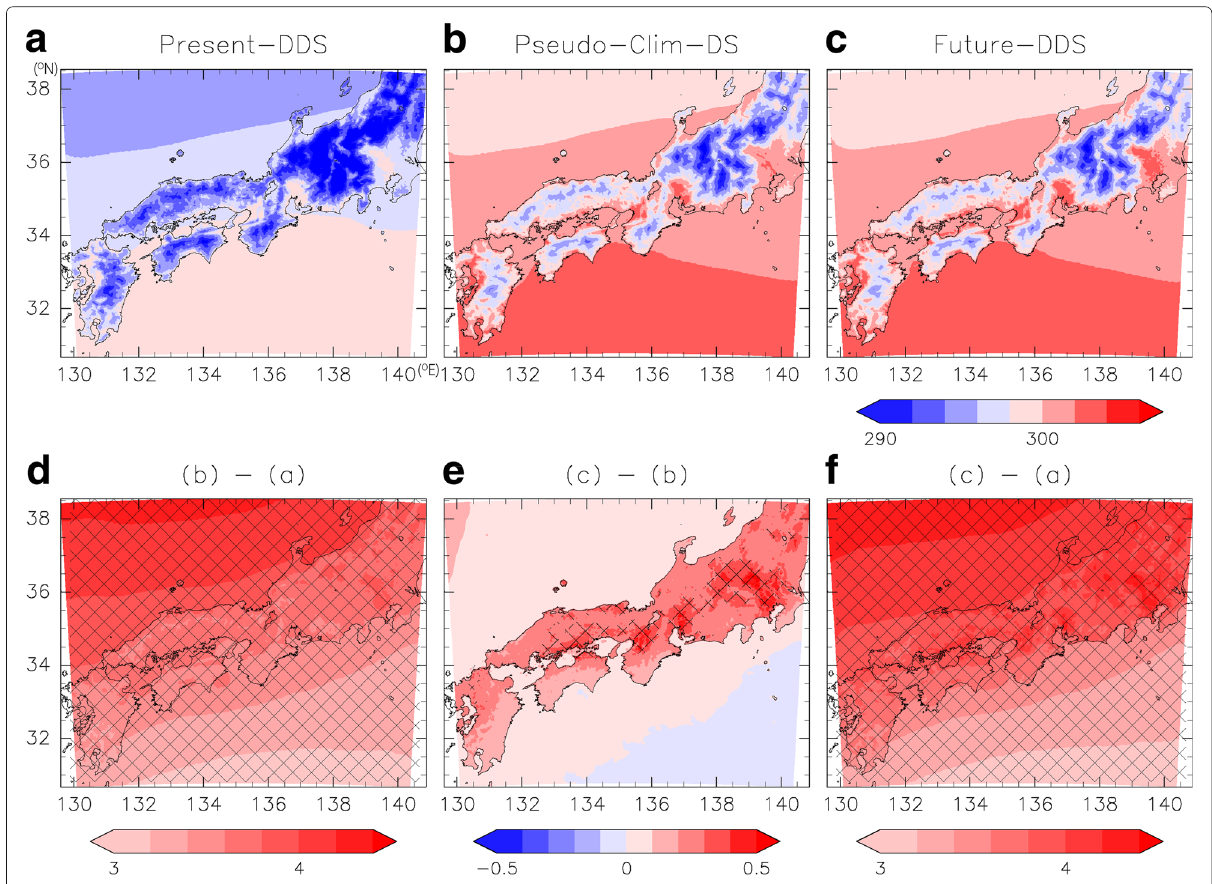
Fig. 5 Horizontal distribution of the 25-year JJAS mean 2-m temperature in a the Present-DDS, b Pseudo-Clim-DS, and c Future-DDS runs, and the difference due to d the climate difference (Pseudo-Clim-DS and Present-DDS), e perturbation difference (Future-DDS and Pseudo-Clim-DS), and f total difference (future and Present-DDS runs). The hatched region in e and f represents the area in which the difference is statistically significant with a 95% confidence